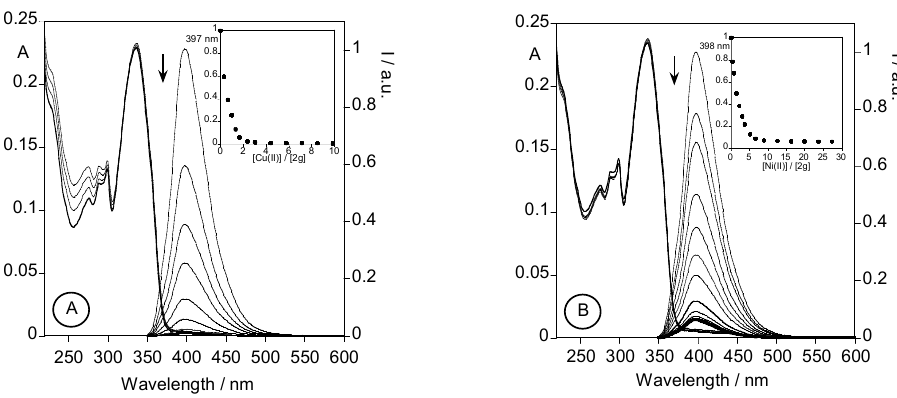
Figure 7. Spectrophotometric titration and fluorimetric titration of an ethanolic solution of 2g with a SO ) (A) and Ni(BF standard solution of Cu(CF 3 2 2 298 K, λ = 336 nm. Inset: normalized emission at 397 and 398 nm, respectively).